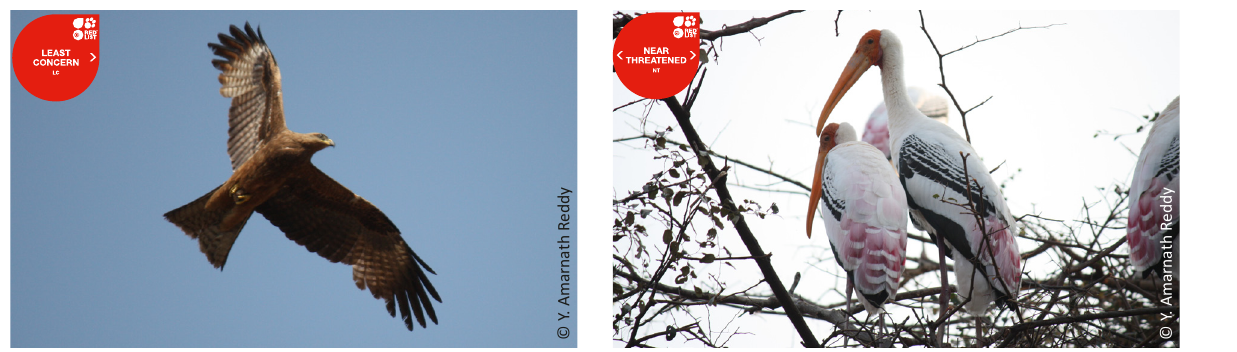
Image 21. Milvus migrans Black